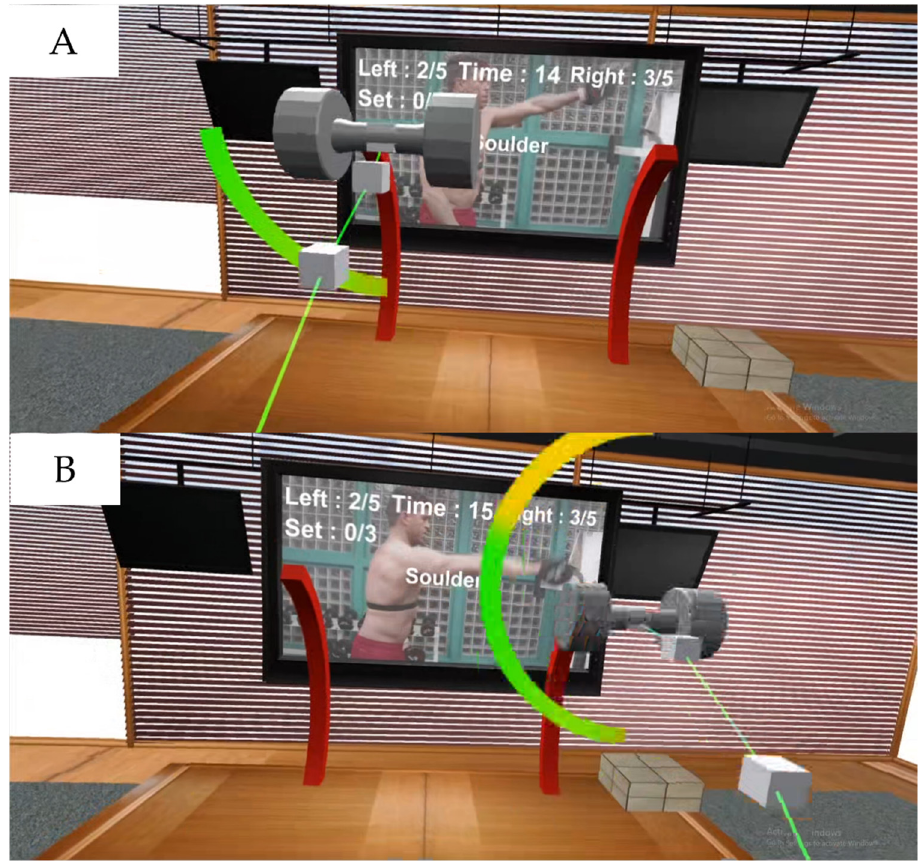
Figure 11. Shoulder curl process. ( A ) Left hand. ( B ) Right hand.